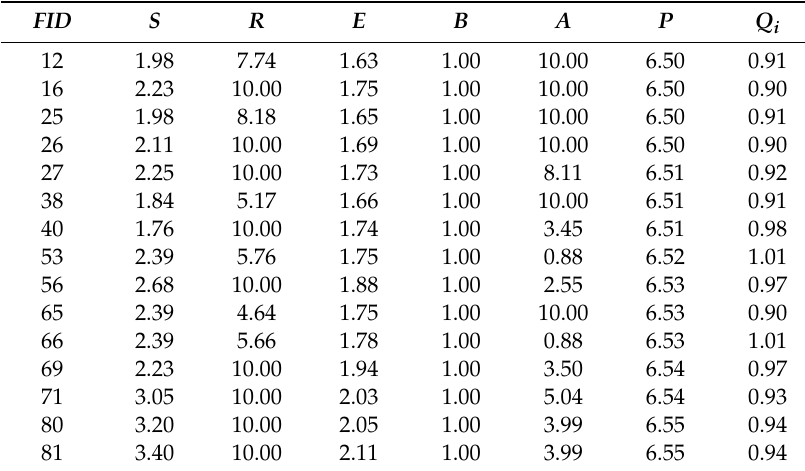
Table 3. Index score of points in a very unsuitable